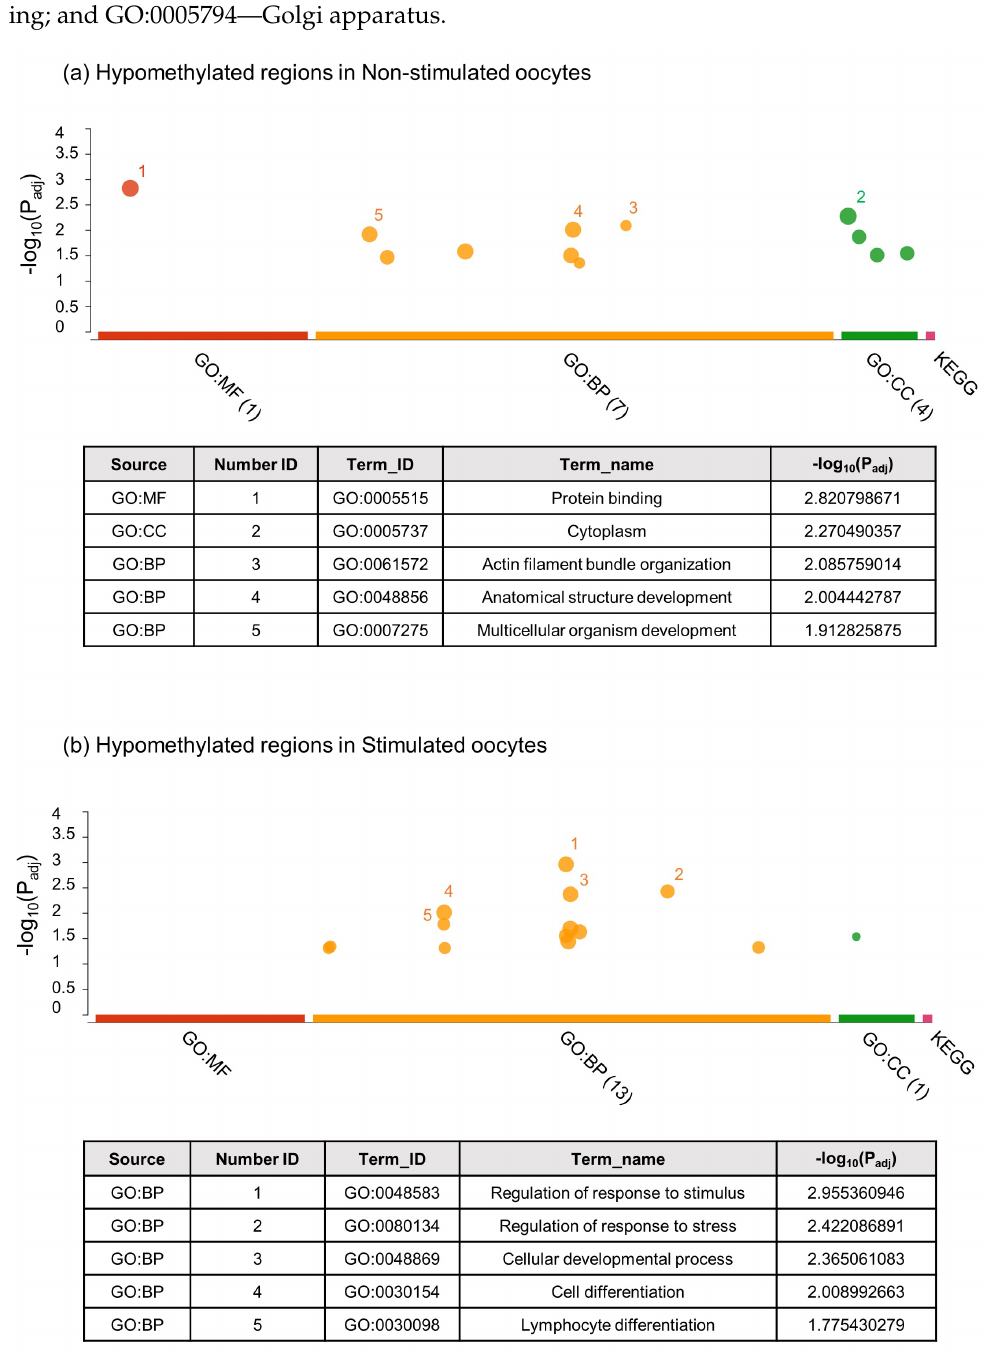
Figure 3. Manhattan plot of g:Profiler enrichment results of hypomethylated DMRs obtained in non-stimulated ( a ) and stimulated oocytes ( b ). GO (BP = biological process (orange colour); MF = molecular function (red colour); and CC = cellular component (green colour)) and KEGG database (pink colour) were used for the analysis. Only terms with a p value < 0.05 are shown. The table below shows the top five enriched representative terms, and the statistical value for each term is indicated by the -Log10 ( p value).